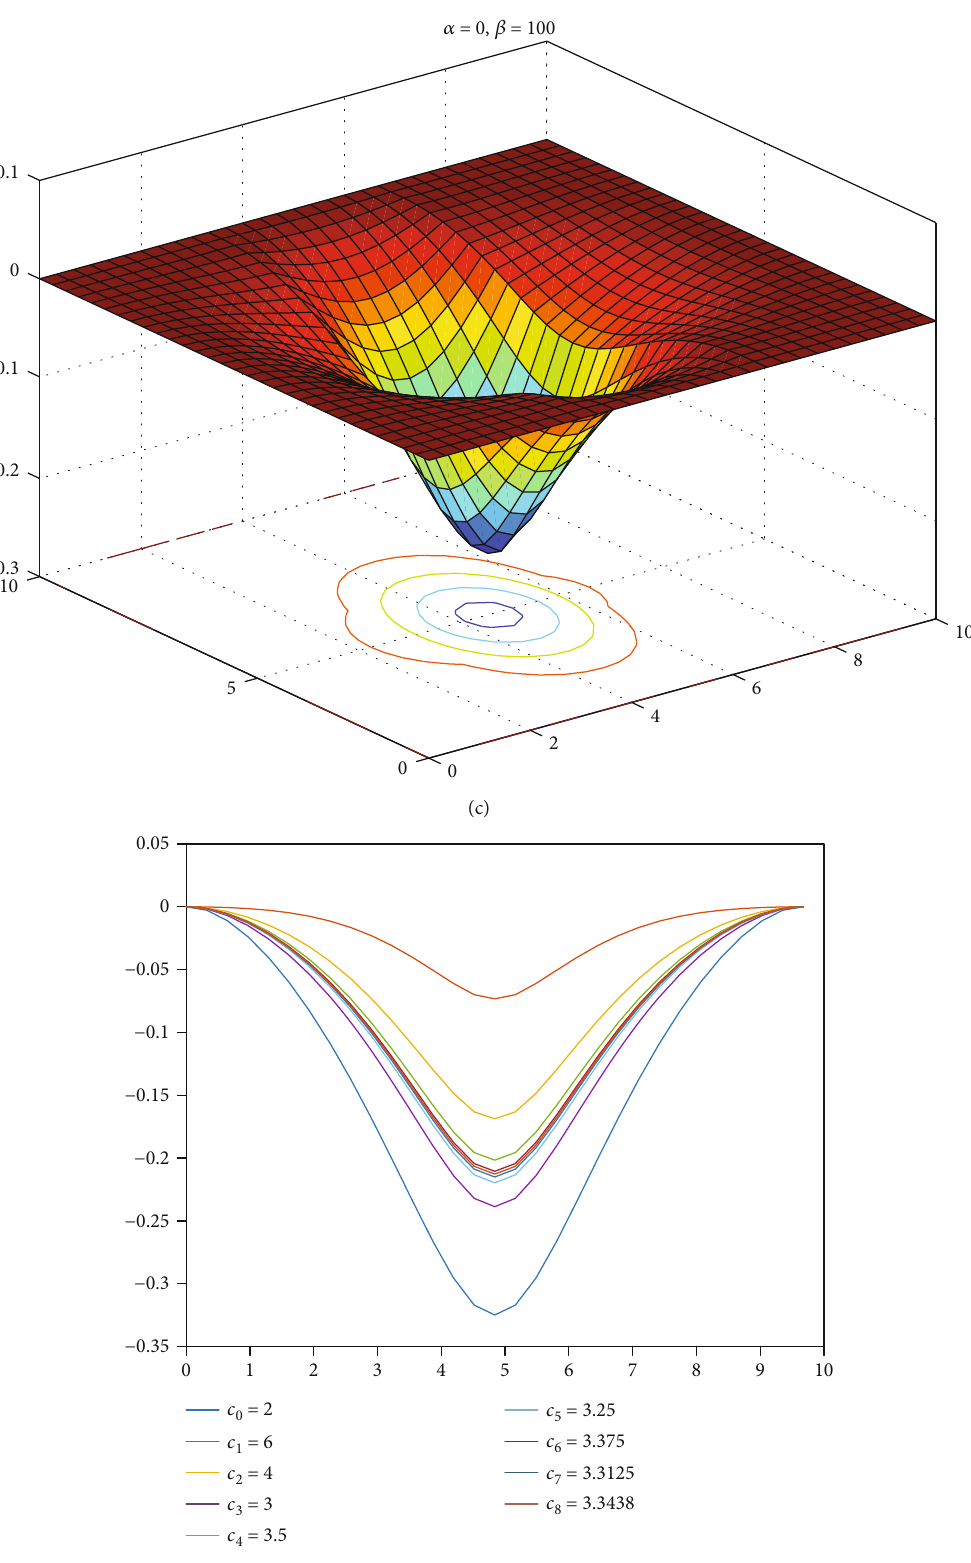
= 2 , (b) c = 6 , (c) c = 3 : 3438 , and (d) bending of the system for Case 1 in the case of α = 0, β = 100 Figure 3: (a) c 0 1 8